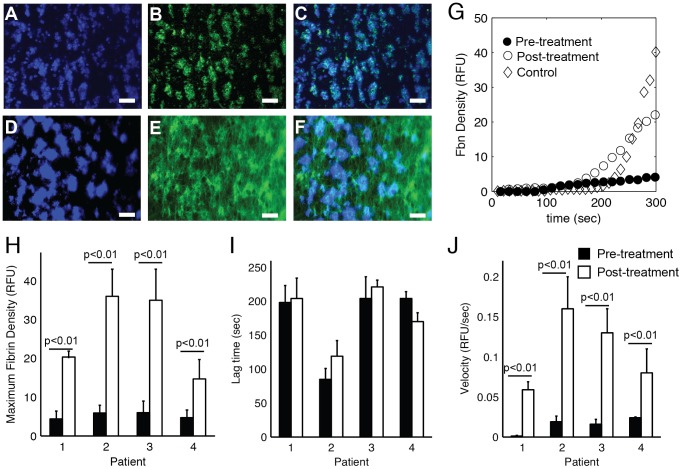
Fibrin deposition dynamics in response to rFVIII treatment.Four patients (1–4) with severe hemophilia where treated with rFVIII (see Methods for doses). Recalcified whole blood was perfused over glass slides coated with 2.3 fmol TF/cm2 and type 1 fibrillar collagen at 100 s−1 for 5 min before and 30 min after treatment with rFVIII. Platelets (blue, anti-CD41), fibrin(ogen) (green, Alexa488-fibrinogen) and their overlay immediately before (A–C) and 30 min. after (D–F) rFVIII injection. (G) Transient fibrin density pre-treatment (•) and post-treatment (○) in comparison to a normal control (◊). The dynamics of fibrin deposition before (black bars) and after (white bars) was characterized by (H) maximum fibrin density, (I) the lag time, and (J) the velocity. Error bars represent standard deviations of n = 3. Lines indicate comparisons between pairs according to the Mann-Whitney U-test.